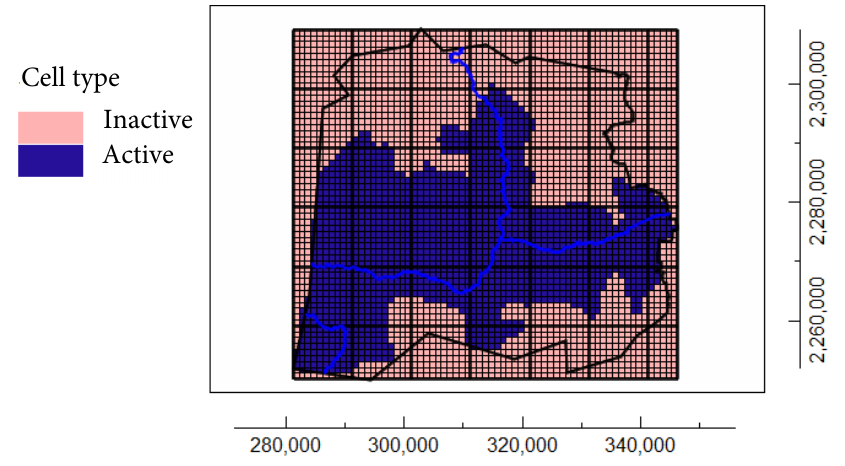
Figure 9. Spatial discretization, plan view of the Figura 2.3: Discretizaci´on espacial, vista en planta del modelo.